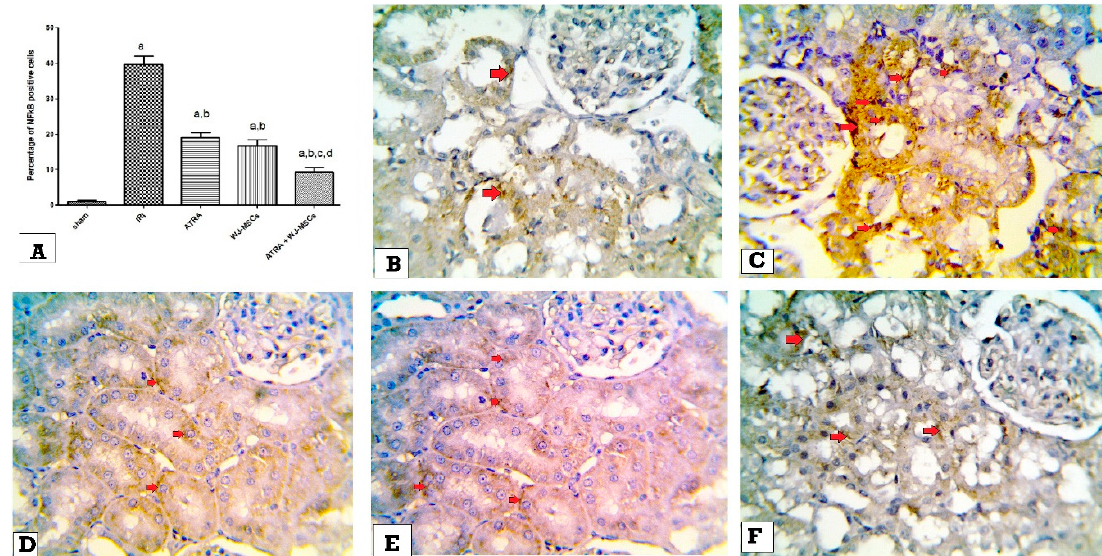
Figure 6. Expression of NFkB in kidney tissues in day 5 group. ( A ) Percentage of NFkB positive cells in different studied groups. a significant vs. sham group, b significant vs. IRI group, c significant vs. ATRA group, d significant vs. WJ-MSCs group. Microscopic pictures of immunostained tissues showing negative expression of NFkB in renal tubular epithelial cells and glomerular cells of sham group (red arrows) ( B ), high brown expression of NFkB in renal tubules of the IRI control group (red arrows) ( C ), moderate expression of NFkB in renal tubules of ATRA group (red arrows) ( D ), mild expression of NFkB in renal tubules of WJ-MSCs group (red arrows) ( E ), and low expression of NFkB in renal tubules of ATRA + WJ-MSCs group (red arrows) ( F ) (high magnification 400×).